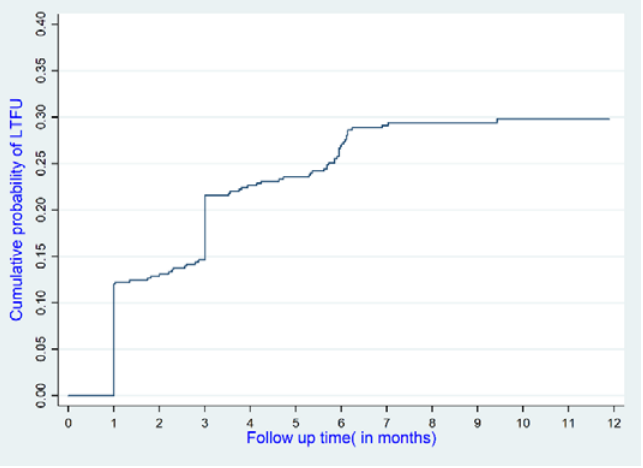
Figure 3. Incidence of Loss to follow up.